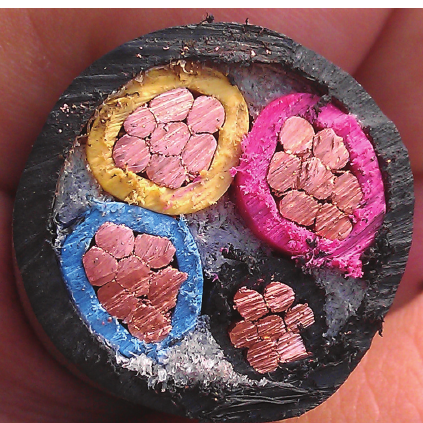
Figure 6: Three-core insulated cable for electrical power transmis- sion.